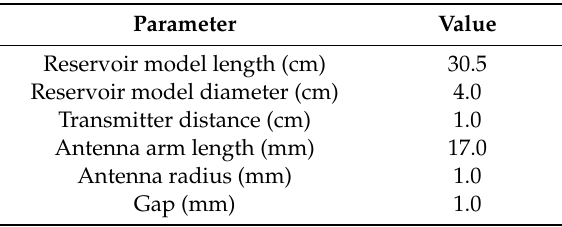
Table 1. Geometric model